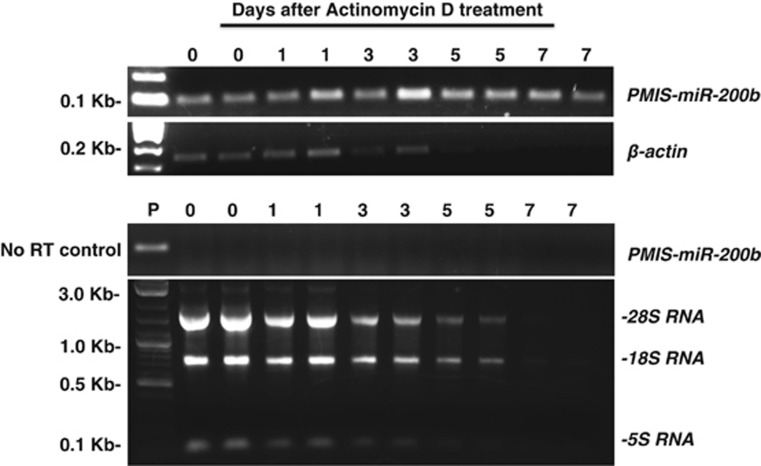
PMIS-miR inhibitors are relatively stable in the cell. Cells stably expressing PMIS-miR-200b were seeded at identical concentrations into six- well plates and subjected to actinomycin D treatment for 7 days. After 1, 3, 5 and 7 days, cells were harvested, total RNA harvested and PMIS-miR-200b was analyzed by RT-PCR (top panel). β-Actin was used as a control. The bottom panel shows the 28 S, 18 S and 5 S RNAs as controls. Another control contained the isolated total RNA without reverse transcription (no RT control) used in the PCR reaction to detect possible PMIS DNA; however, no PMIS DNA was detected in the samples.